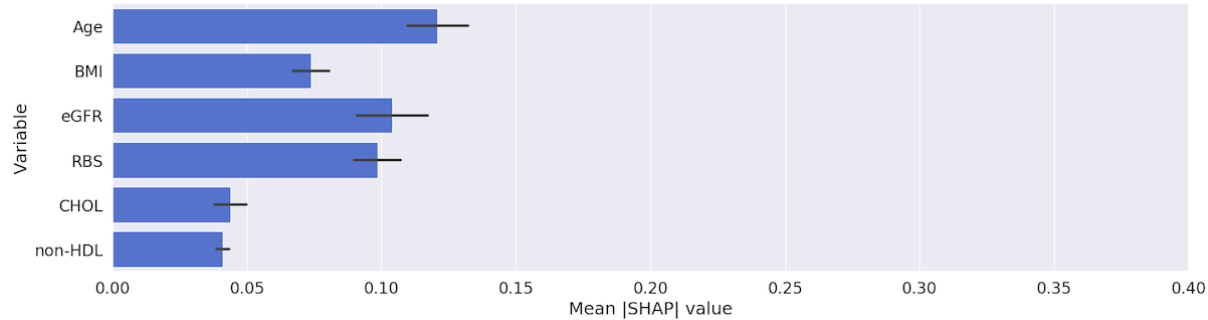
elevation risk can be 1c